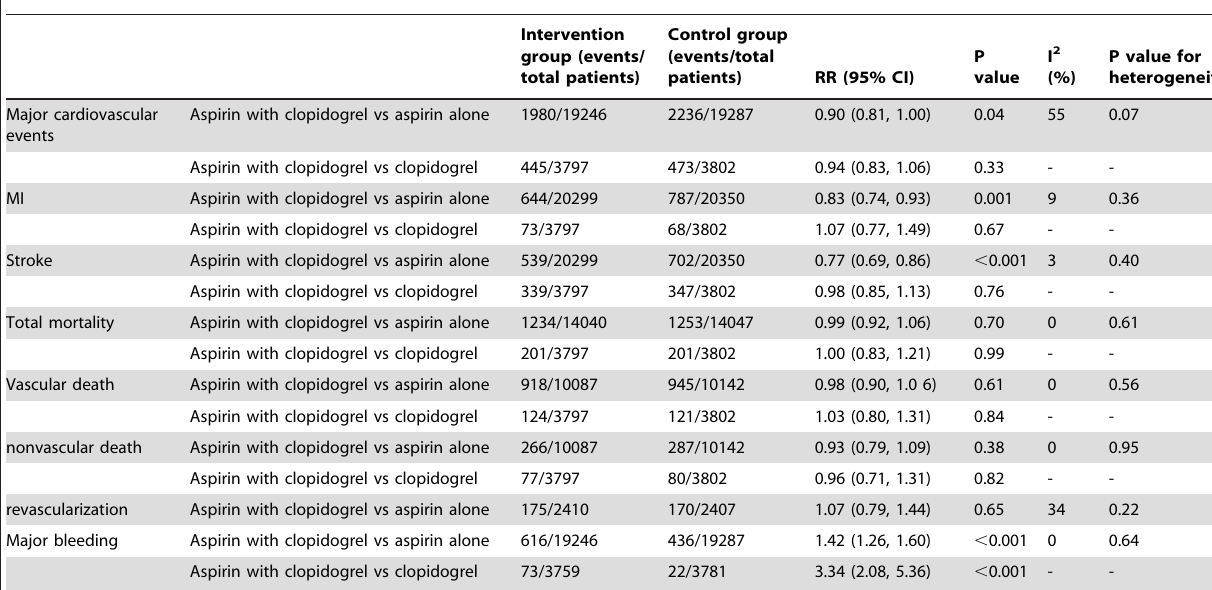
Table 2. Evidence profile for Aspirin and Clopidogrel on the risk of vascular